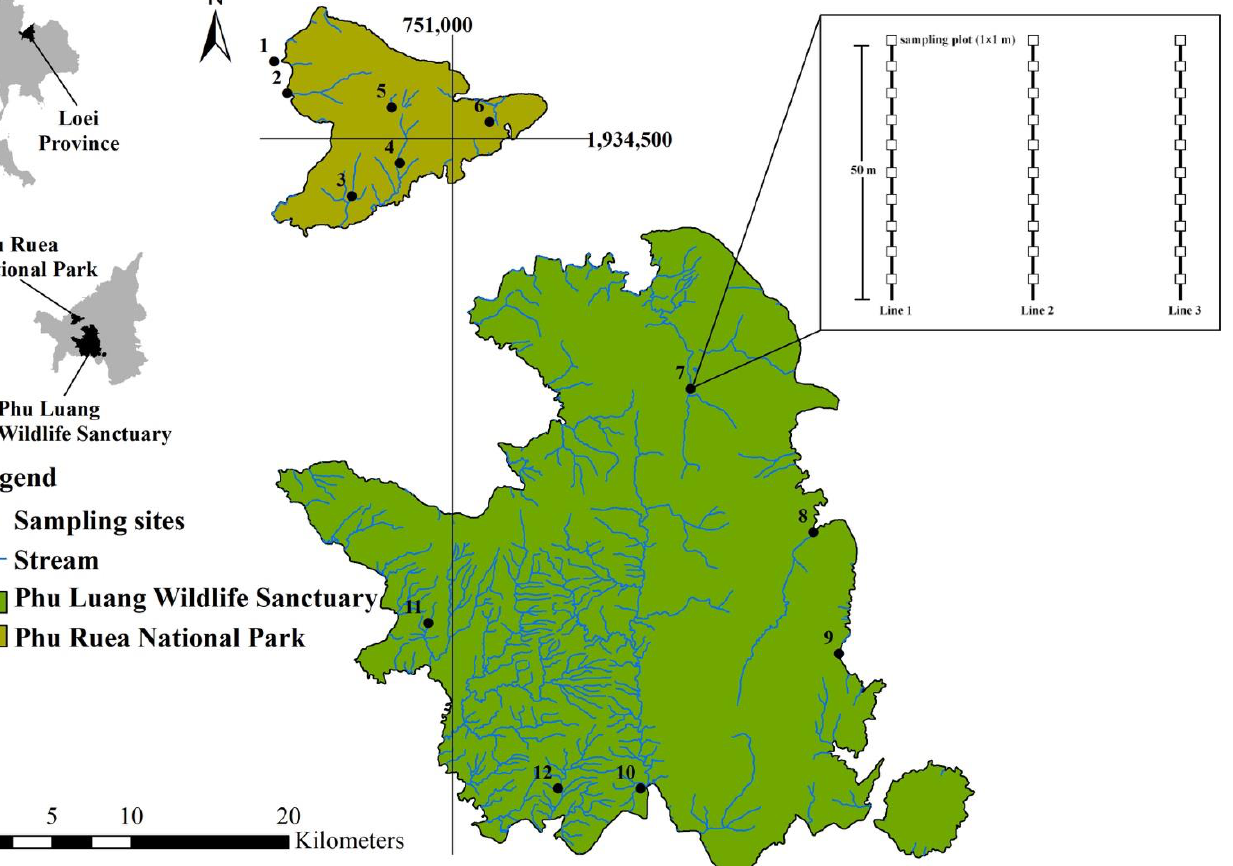
Figure 1. Map of Thailand showing sampling sites in Phu Luang Wildlife Sanctuary (PL) and Phu Ruea National Park (PR), Loei Province: (1) Huay Tiew; (2) Huay Kawak; (3) Huay Sai khao; (4) Huay Phai; (5) Huay Toei; (6) Huay Nam khan; (7) Huay Nam San; (8) Huay Nam Thop; (9) Huay Nam Khai; (10) Huay Nam Loei; (11) Huay Sak and (12) Huay Pla Ba. On the right side of this figure is a sampling site that consists of three line transects with 10 sampling plots in each line transect.